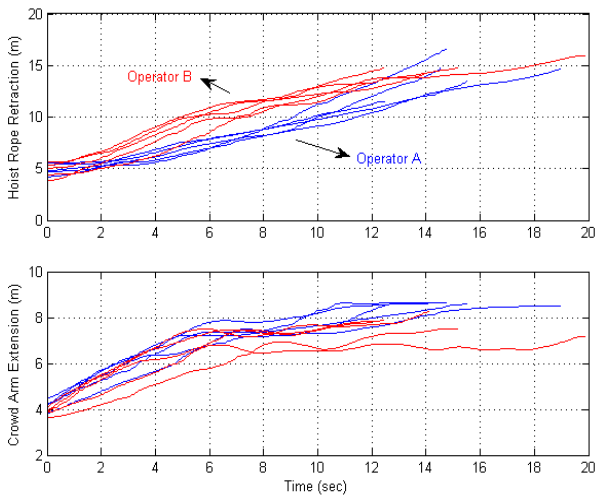
Figure 14. Hoist rope retraction and crowd arm extension for Operators A and B.